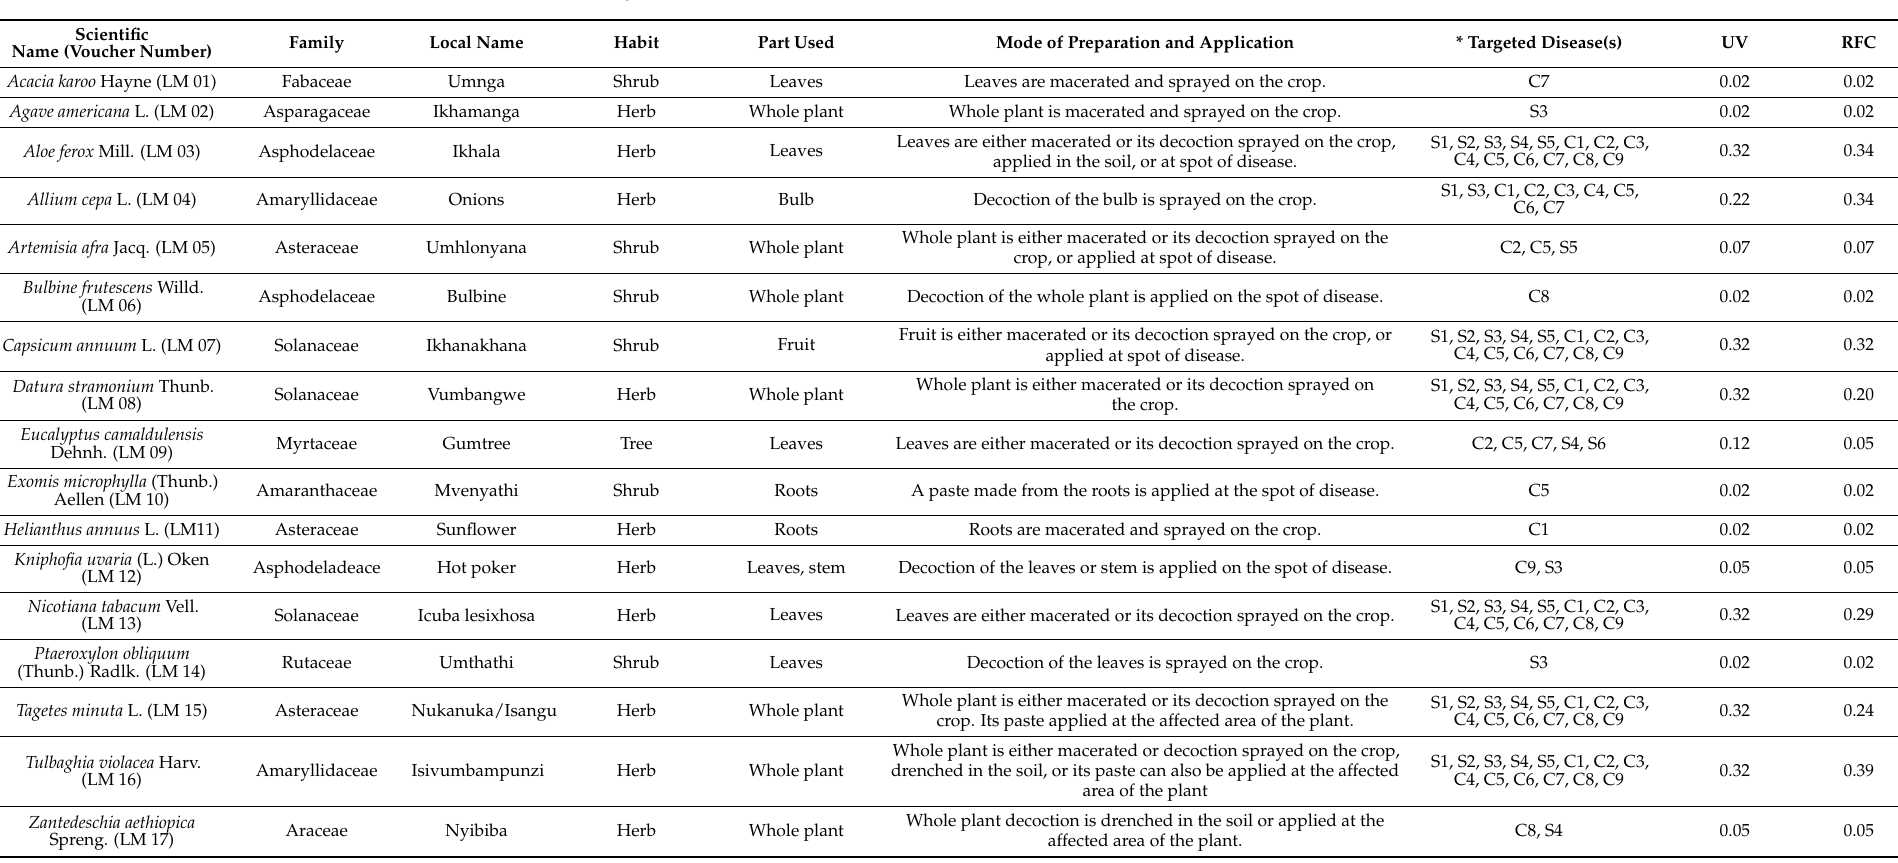
Table 2. Inventory of plants used by subsistence farmers in mitigating diseases of cabbage and spinach in OR Tambo Municipality, South Africa. Verification of the botanical names was done using the ‘World Flora Online’